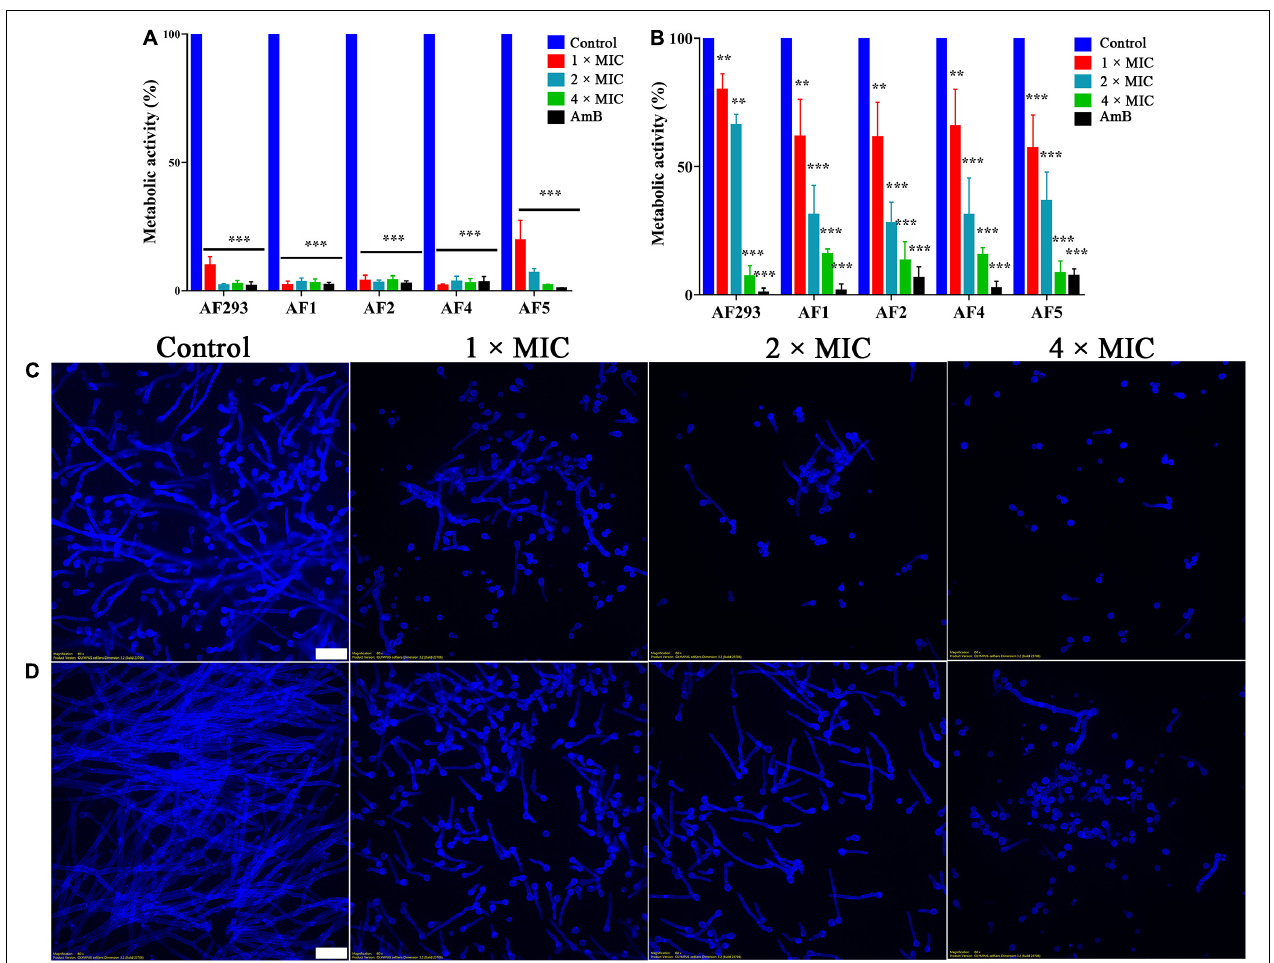
FIGURE 2 | Effect of sodium new houttuyfonate (SNH) on biofilm. Readings of colorimetric XTT reduction assays at 492 nm are expressed as the percentage metabolic activity of the control. (A) Effect of SNH on the biofilm formation of the AF293, AF1, AF2, AF4, and AF5 strains. (B) Effect of SNH on preformed biofilms of the AF293, AF1, AF2, AF4, and AF5 strains. Results represent the average of three independent experiments ± SD, and the level of statistical significance was set at * P < 0.05, ** P < 0.01, and *** P < 0.001. CLSM observation of the AF293 strain in (C) biofilm formation and (D) the preformed biofilm treated with 1 × , 2 × , and 4 × MIC SNH, respectively. Biofilms were stained with 1mL calcofluor white stain supplemented with 20 µ L 10% KOH. Scale bar = 20 µ